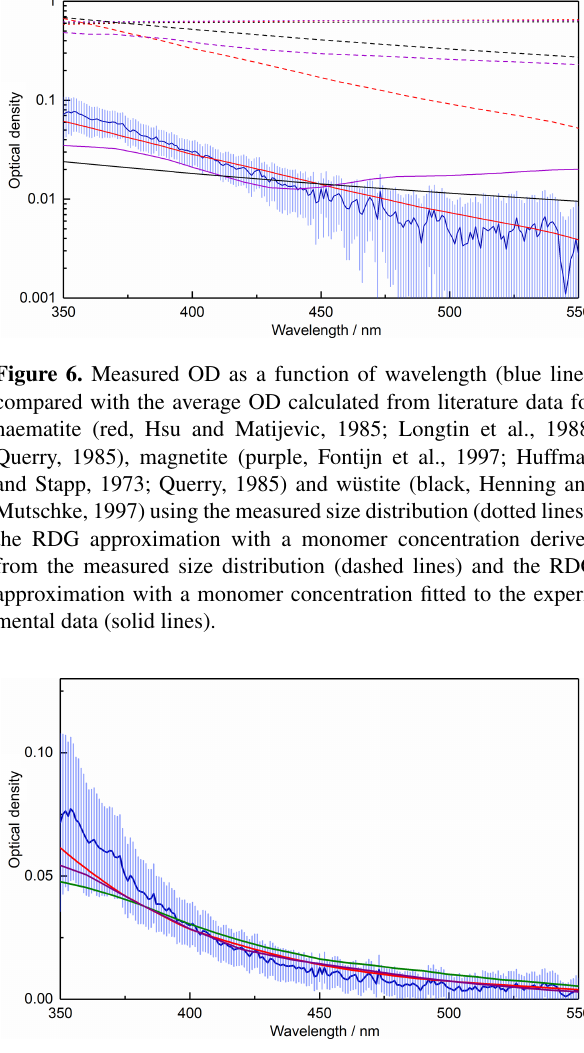
Figure 7. Measured OD (blue line), scaled maghemite OD from Jain et al. (2009) (green line) and scaled maghemite OD from Tang et al. (2003) (purple line), as a function of wavelength. Also shown is the average OD calculated from literature data for haematite (red, Hsu and Matijevic, 1985; Longtin et al., 1988; Querry, 1985) using the RDG approximation with a monomer concentration fitted to the experimental data (as shown in Fig.